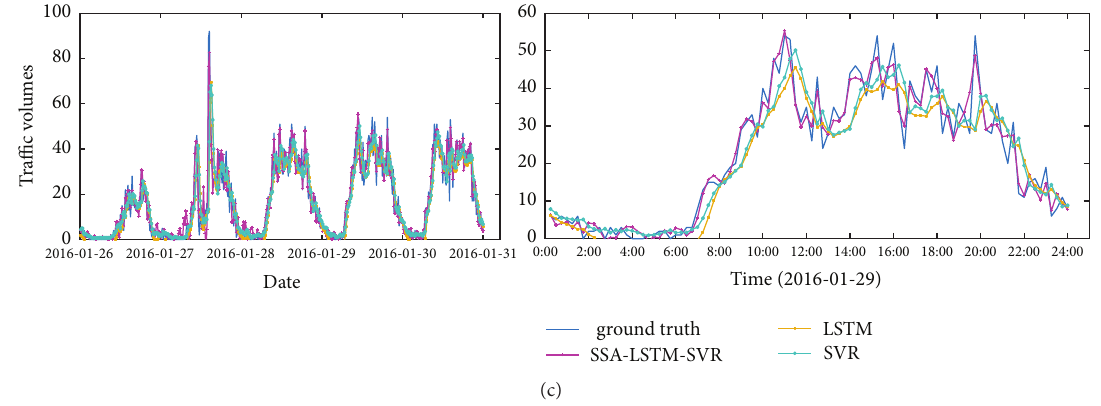
Figure 6: The prediction results of SVR, LSTM, and